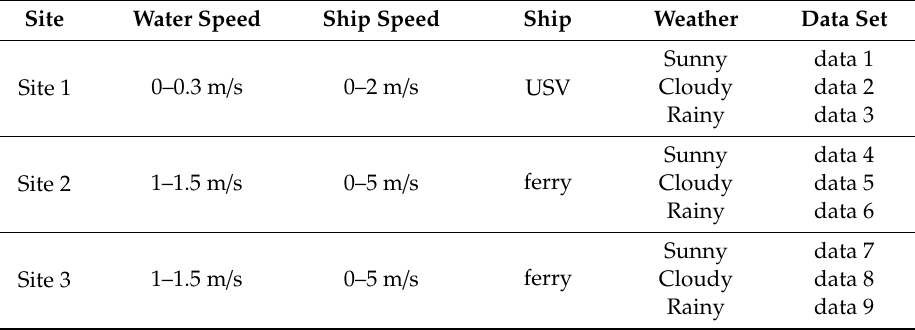
Table 2. Experimental sites and